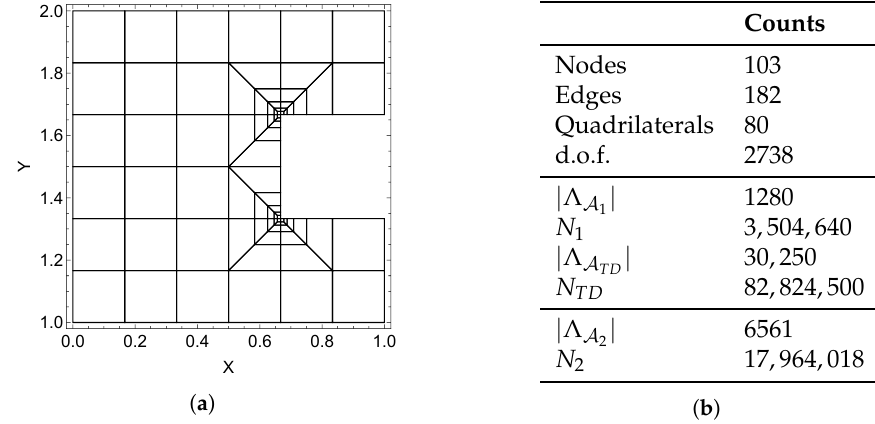
Figure 2. Graded mesh used in all simulations. N 1 and N 2 refer to the dimensions of the linear systems of the two configurations, respectively, and N TD is the dimension of the first case with the total degree selected and isoTD ( · , K = 2 ) . ( a ) Geometrically graded mesh used in all simulations and ( b ) discretization data. Sizes of the mesh components and stochastic basis used at deterministic p =